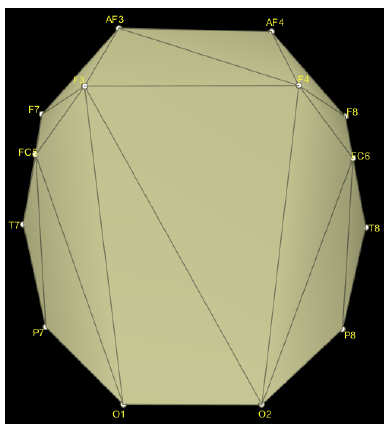
Figure 1. The names and positions of the electrodes.